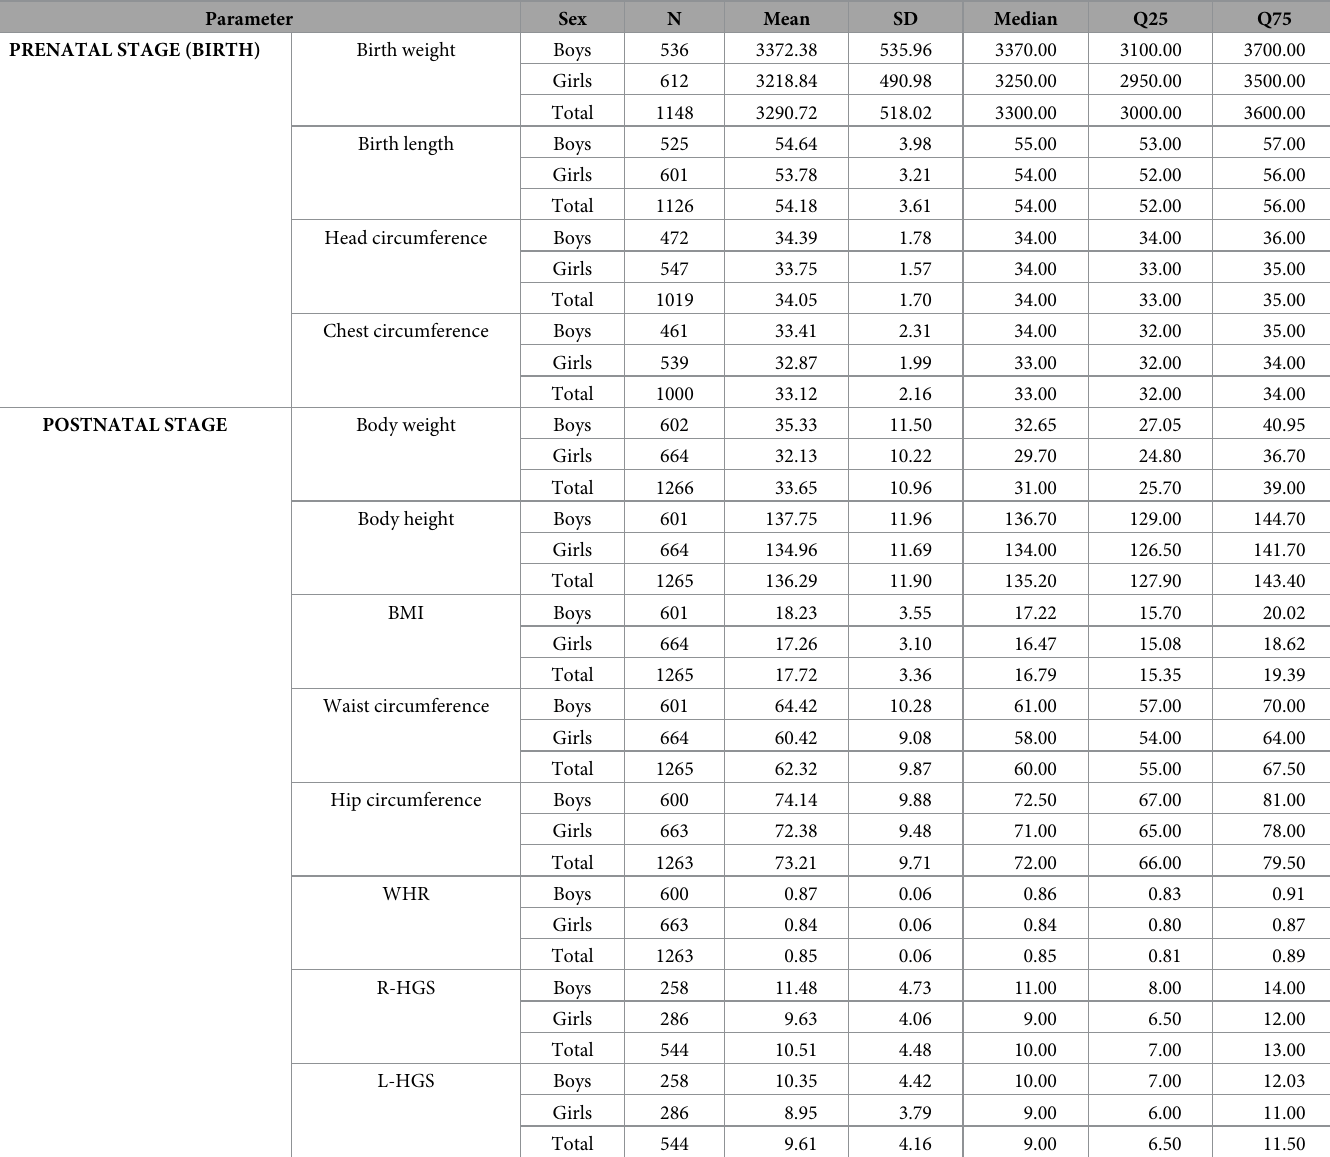
Table 1. Characteristics of body size